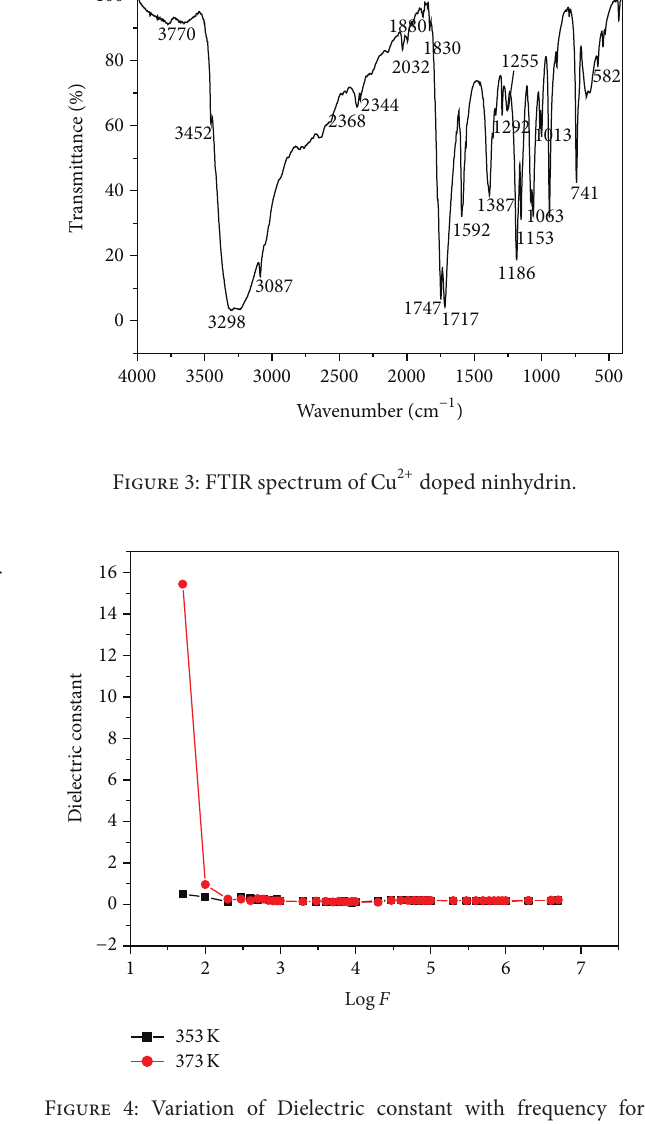
F 4: Variation of Dielectric constant with frequency for different